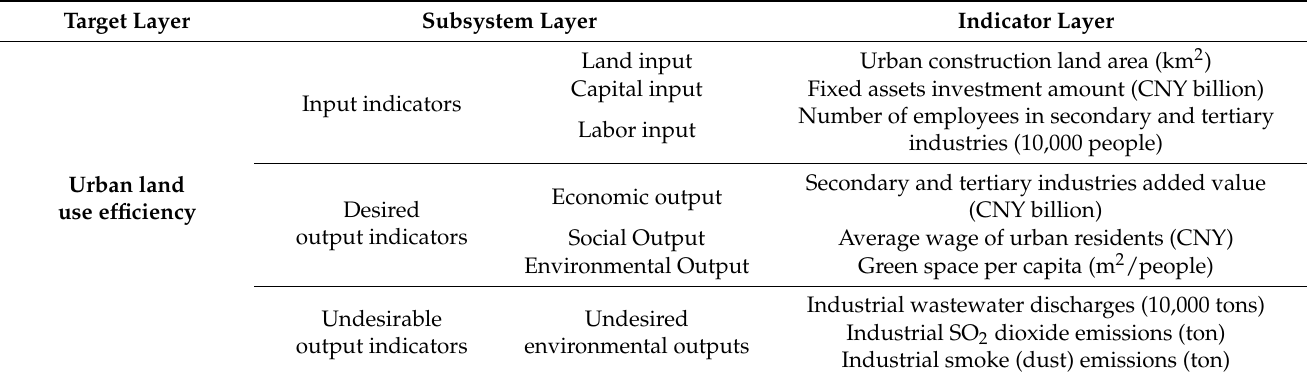
Table 1. Evaluation index system of the ULUE.